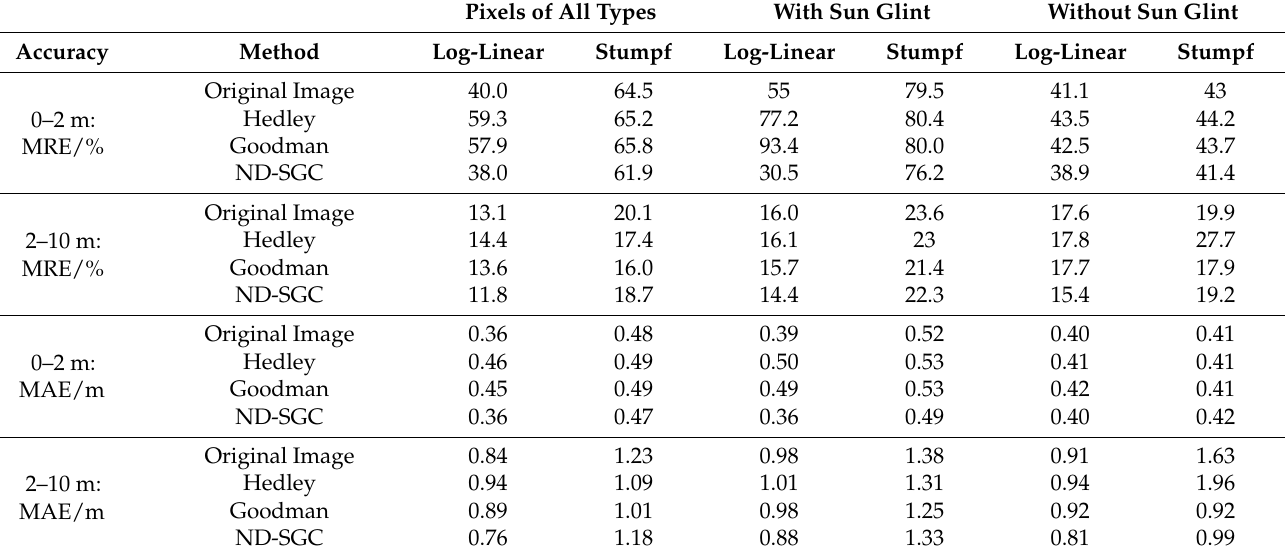
Table 3. Evaluation of the accuracy of water depth inversion of the extremely shallow water and shallow water 2–10 m of the Sentinel-2 image in the Dongdao Island region. Pixels of All Types With Sun Glint Without Sun Glint Log-Linear Stumpf Log-Linear Stumpf Log-Linear Stumpf